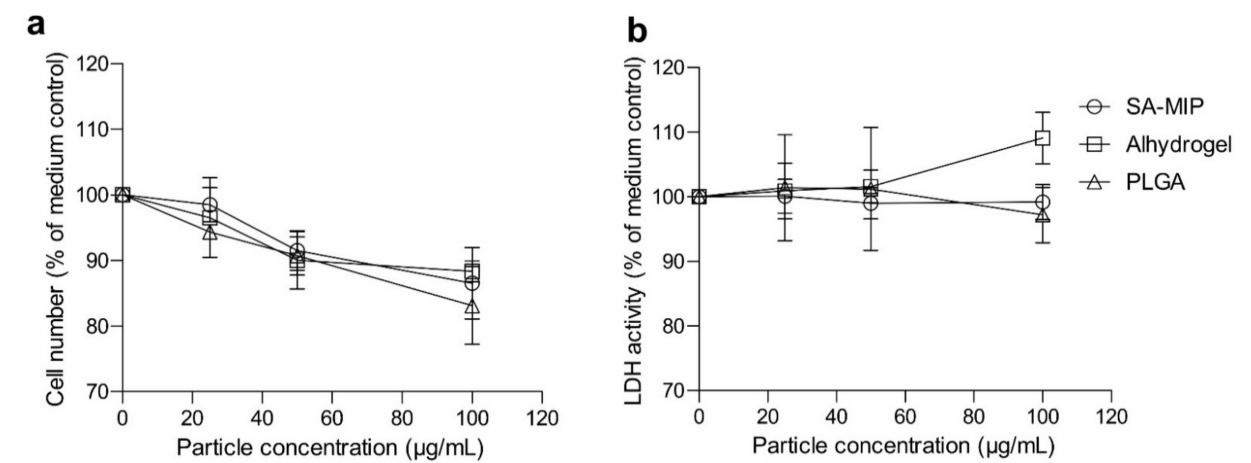
Figure 5. Viable THP-1 cells after incubation with SA-MIPs, Alhydrogel or PLGA particles for 24 h. THP-1 cells were either counted ( a ) or the release of lactate dehydrogenase (LDH) into the culture medium was measured ( b ). THP-1 cells were incubated with 0 µ g/mL, 25 µ g/mL, 50 µ g/mL or 100 µ g/mL SA-MIPs, Alhydrogel or PLGA for 24 h. Results shown as % of the medium control and the average of three independent experiments with ±